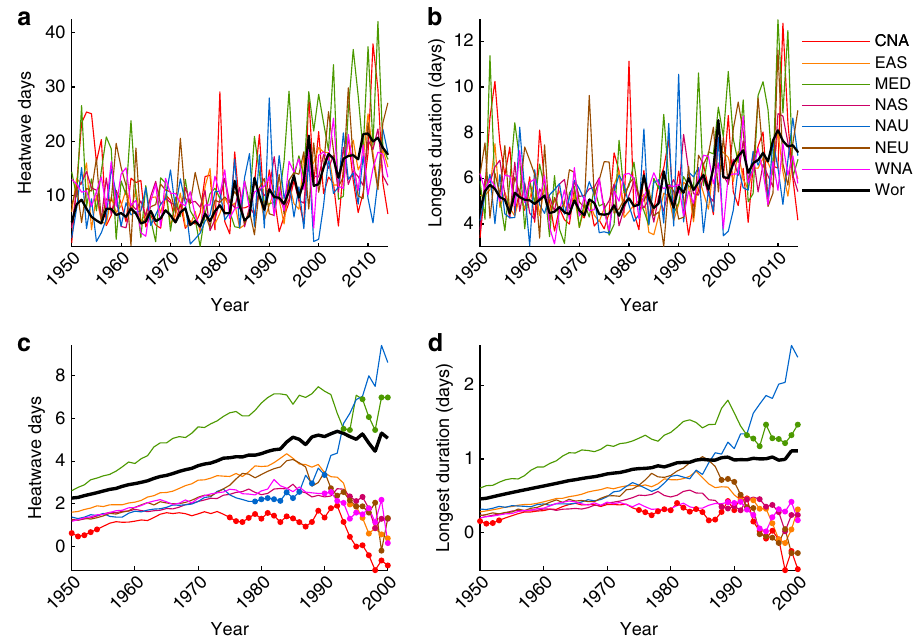
Fig. 3 Heatwave regional and global timeseries. Selected timeseries of heatwave days ( a ); and length of longest heatwave ( b ). Decadal trends in heatwave days ( c ); and length of longest heatwave ( d ) commencing yearly between 1950 and 2000 and truncating in 2017. All values are calculated for the global observational dataset Berkeley Earth (see “ Methods ” ). Closed circles in ( c ) and ( d ) indicate when trends commencing in that year are NOT statistically signi fi cant at the 5% level (see “ Methods ” ). Regions displayed are Central North America (CNA), East Asia (EAS), Mediterranean (MED),